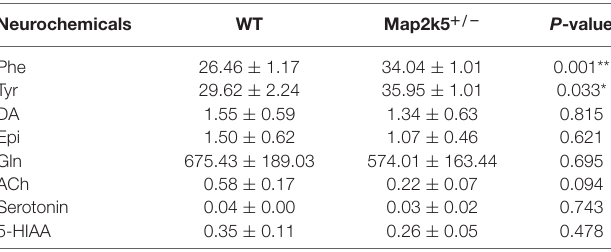
TABLE 1 | Levels of phenylalanine (Phe), tyrosine (Tyr), dopamine (DA), epinephrine (Epi), serotonin, and its metabolite 5-HIAA in the striatum.